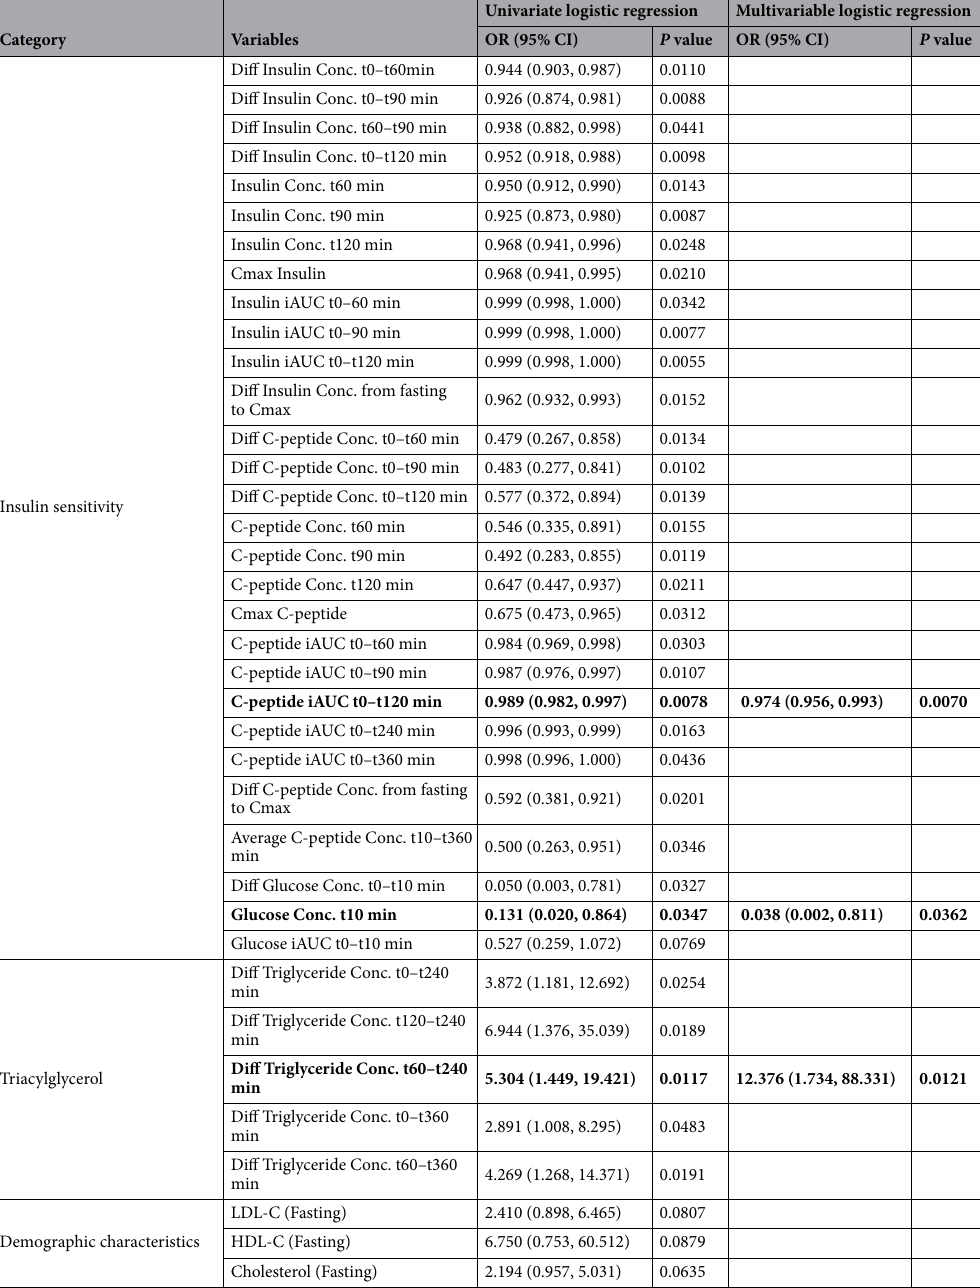
Table 5. Potential candidate predictors of subclinical atherosclerosis in females (n = 46) assessed using univariable logistic regression. Odds ratios are expressed per standard deviation increase in each continuous risk factor. Highlighted variables are independent risk predictors of subclinical atherosclerosis admitted by stepwise selection into the multivariable logistic regression models. OR, Odds ratio; CI, Confidence interval; iAUC, incremental area under curve; Cmax, Peak concentration; LDLC3, Low-density lipoprotein cholesterol; HDLC4, High-density lipoprotein cholesterol. Significant values are in